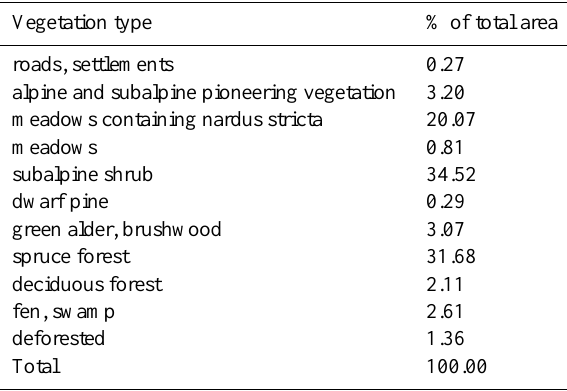
Table 1. Vegetation in the L¨ohnersbach